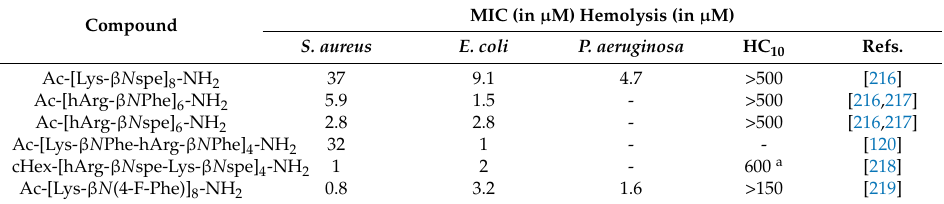
Table 6. Antimicrobial and hemolytic activity of representative α -peptide/ β -peptoid hybrids.